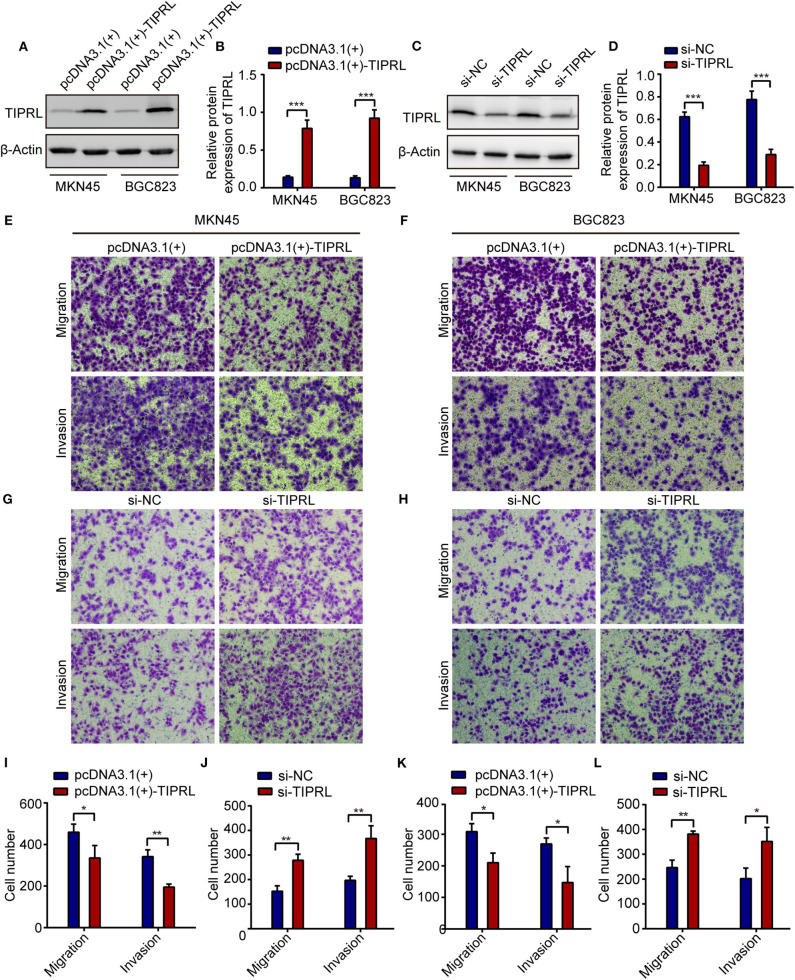
TIPRL attenuates migration and invasion of gastric cancer cells. (A–D) The MKN45 and BGC823 cells were transfected with TIPRL-expressing vector [pcDNA3.1 (+)-TIPRL], TIPRL siRNA, and the respective control vector. The protein levels of TIPRL were examined by WB (***P < 0.001). (E,F,I,K) Expression of TIPRL inhibited the migration and invasion of MKN45 and BGC823 cells, as determined by transwell migration and matrigel invasion assays (t-test, *P < 0.05; **P < 0.01). (G,H,J,L) siRNA-mediated knockdown of TIPRL promoted the migration and invasion of MKN45 and BGC823 cells (t-test, *P < 0.05; **P < 0.01). All experiments were performed in triplicate. Error bars, SD.